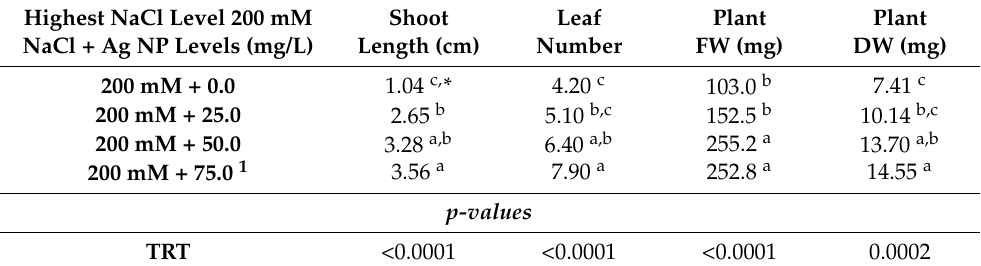
Table 2. The growth parameters of Q6 quinoa plantlets grown under the highest NaCl level after adding different levels of Ag NPs.